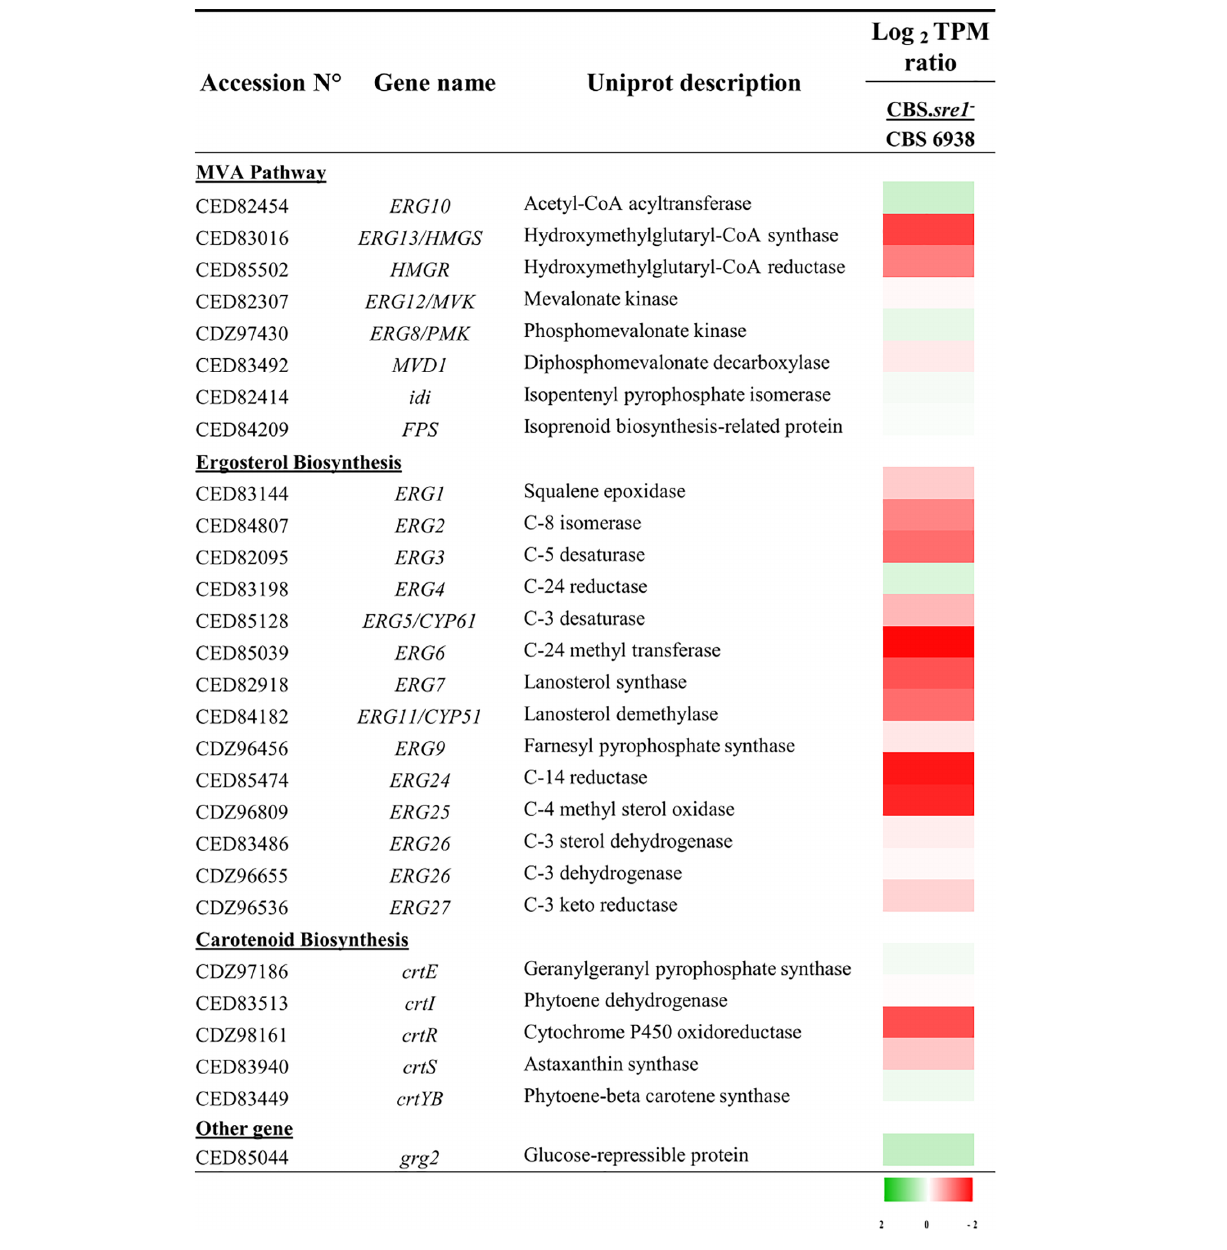
FIGURE 6 | Heat map presentation of gene expression of genes of the mevalonate pathway, and sterol and carotenoid biosynthesis. The values are normalized to the wild-type strain and expressed in Log 2 TPM (Transcripts per million). The color gradient code indicates in green, the transcripts that increase and in red,